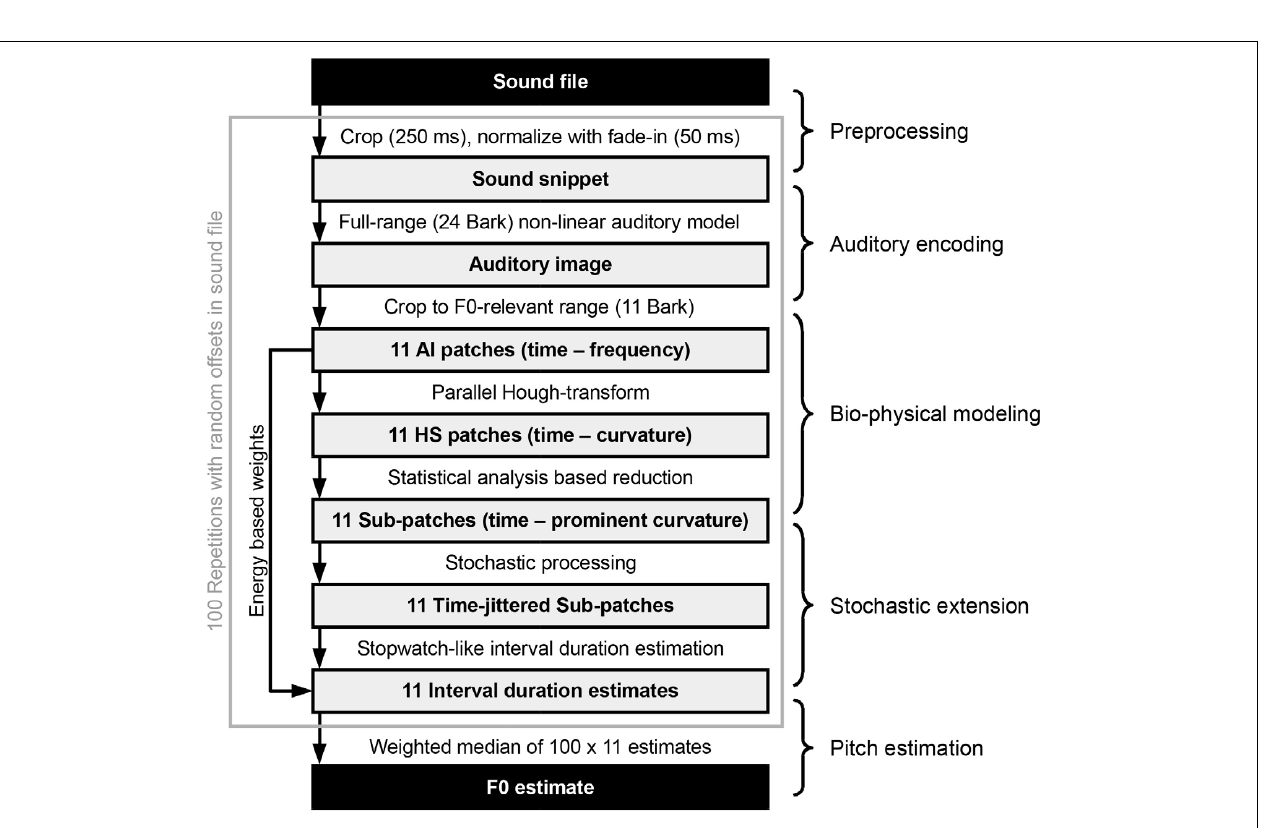
Frontiers in Neuroscience |